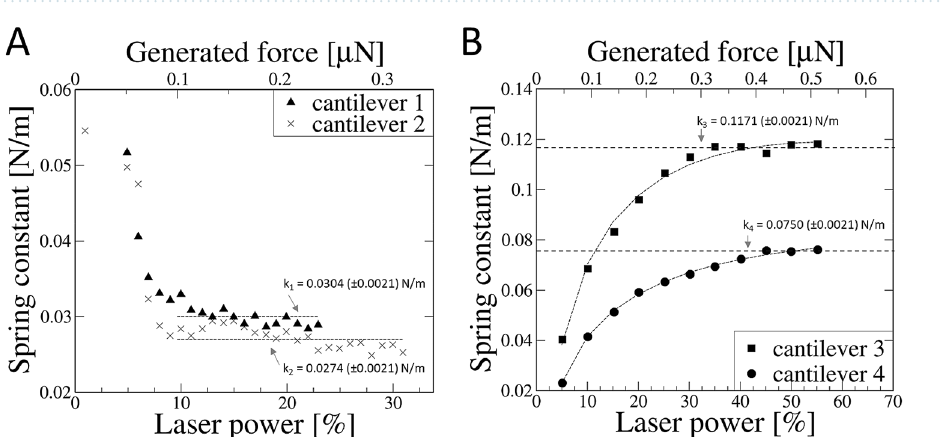
Figure 5. The dependence of the force constant (k) on the OT laser power/generated force for A: rectangular cantilevers (CSG10, NT-MDT) modified to colloidal probes, and B: triangular (V-shape) cantilevers (PNP-TR- TL-SPL, NanoWorld) modified to colloidal